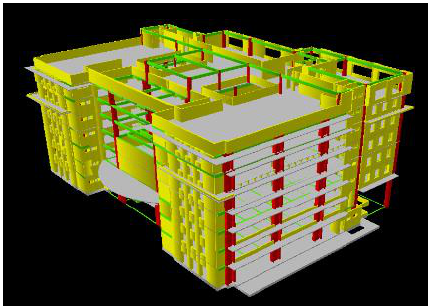
Figure 9. Isometric View of the As-Planned Model of UPCA (walls - yellow, columns - red, beams - green, slab/floor – gray). For the alignment of the as-planned and as-built 3D models, both were georeferenced using GCPs established from the horizontal control survey. A total of seven (7) GCPs were established to of the as-built 3D models were georeferenced separately.